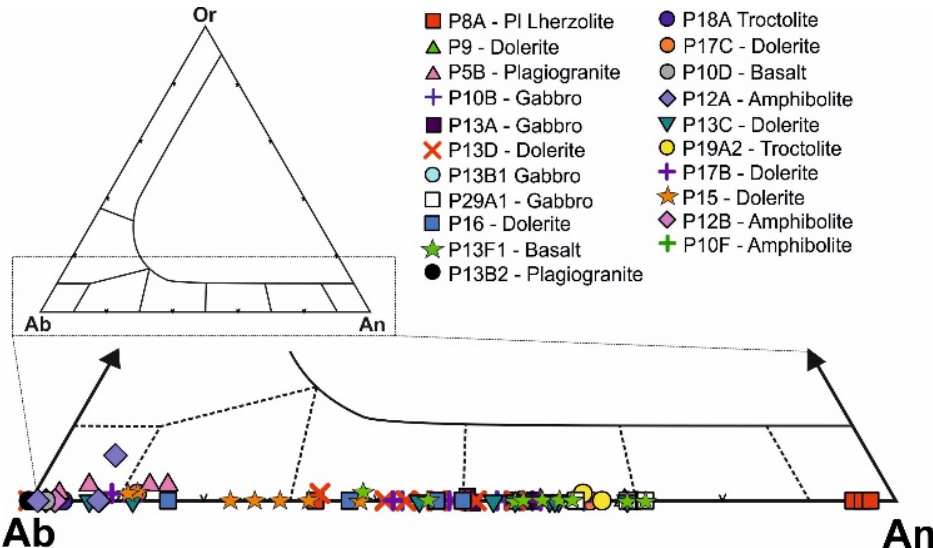
Figure 24. Plagioclase chemistry.